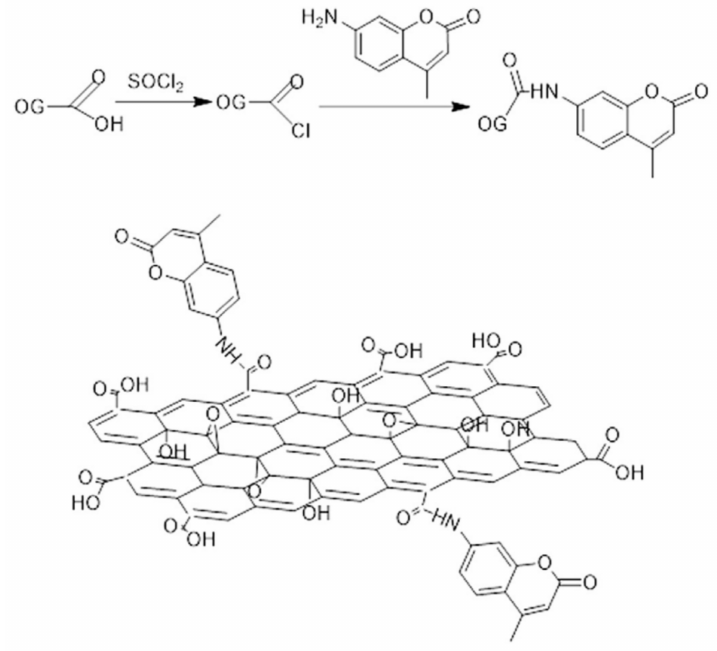
Figure 13. Synthesis of the GO-NH-COUR (Reproduced with permission from ref. [64]. Copyright 2015 Elsevier